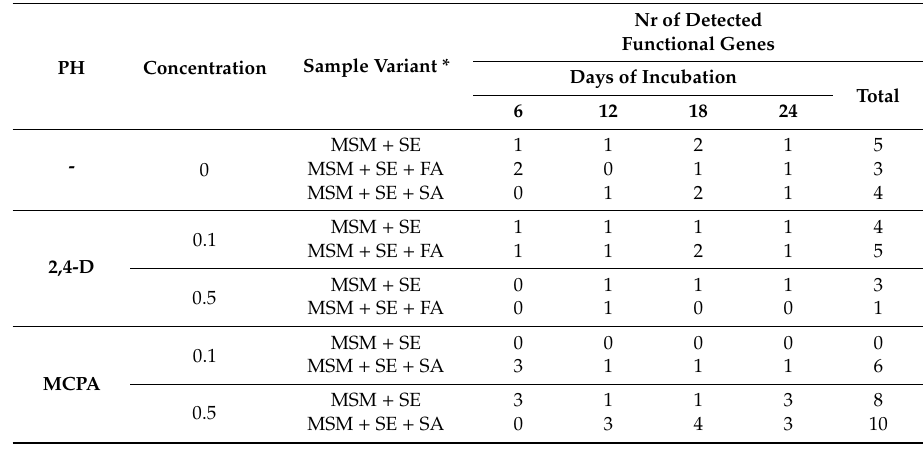
Table 4. Number of Di ff erent Functional Genes Present in Studied Samples After 6, 12, 18, 24 Days of Incubation and Total Number of Detected Functional Genes.